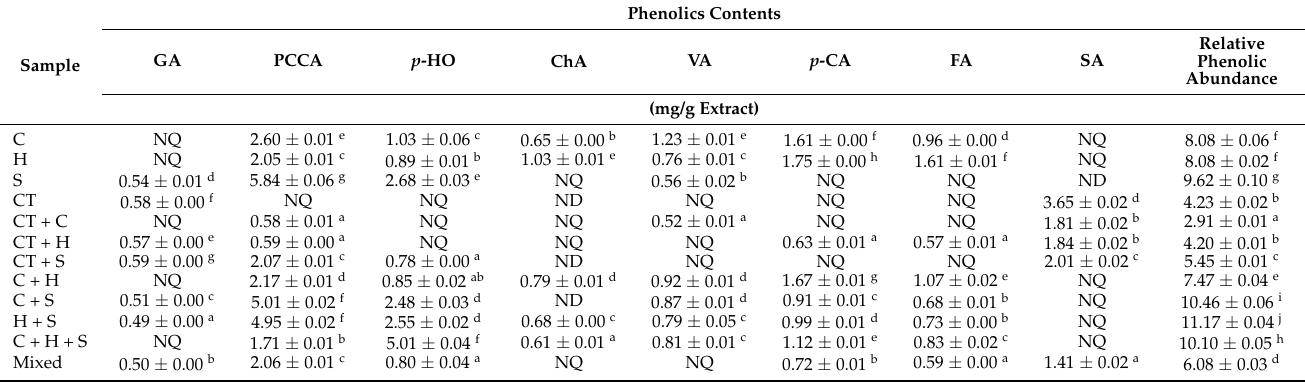
Table 1. Phytochemical compositions analyzed using HPLC of difference extracts obtained from purple corn and butterfly